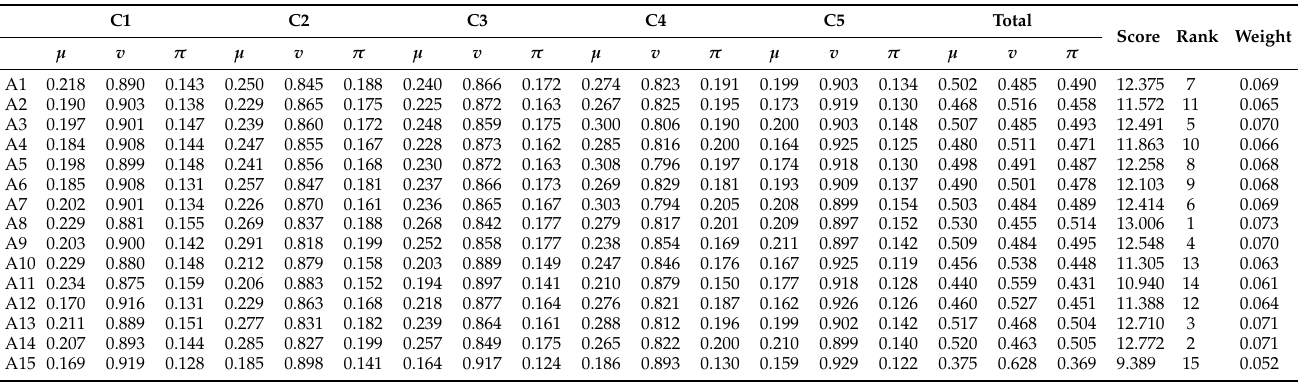
Table A2. Partial SF-AHP